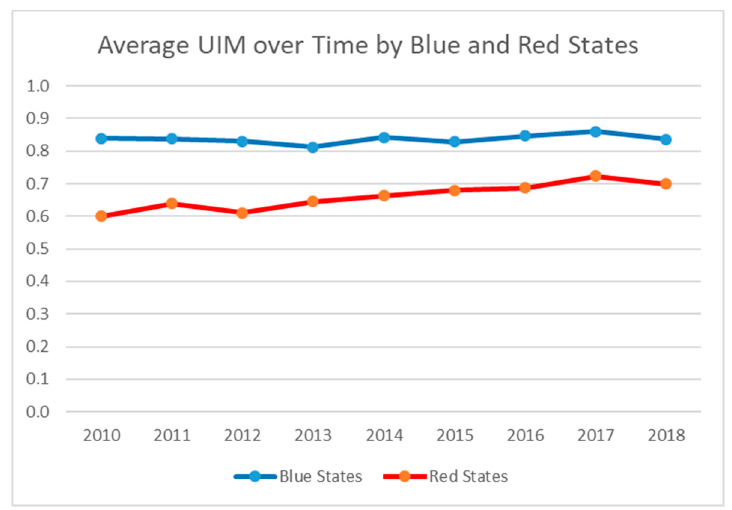
Figure 3. Average Unified Index Scores of Blue and Red States from 2009–2018.